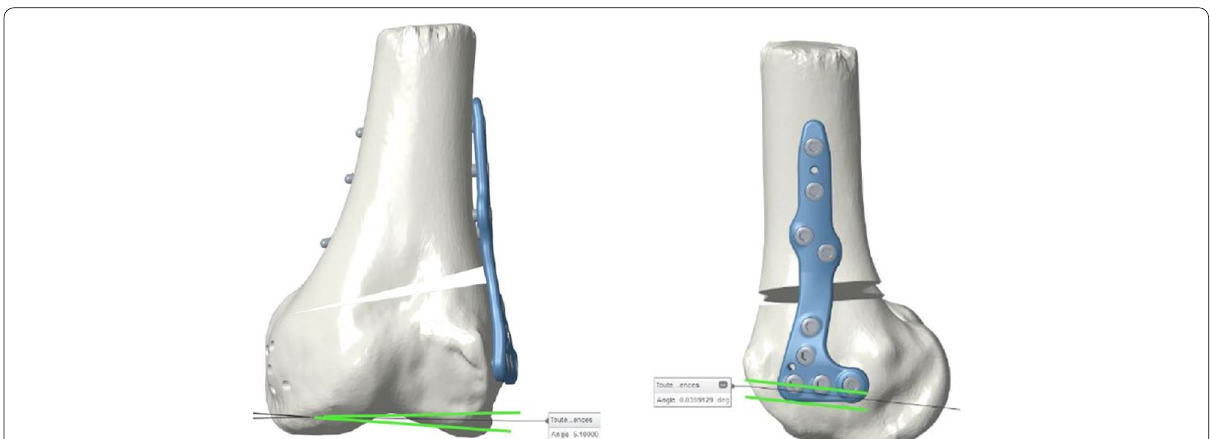
Fig. 1 Within the 3D planning process, the plate position, the resection plane, the degree of correction, as well as the screw positions were virtually planned